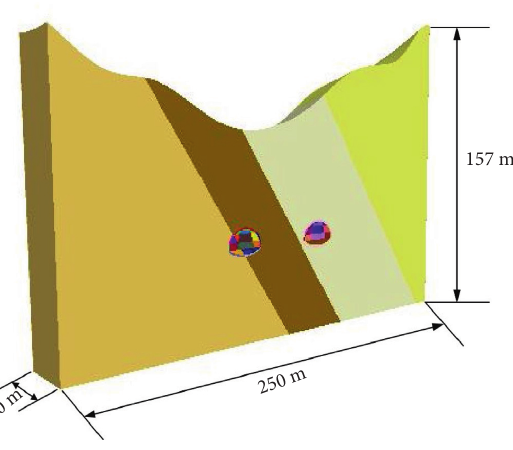
Figure 3: Numerical